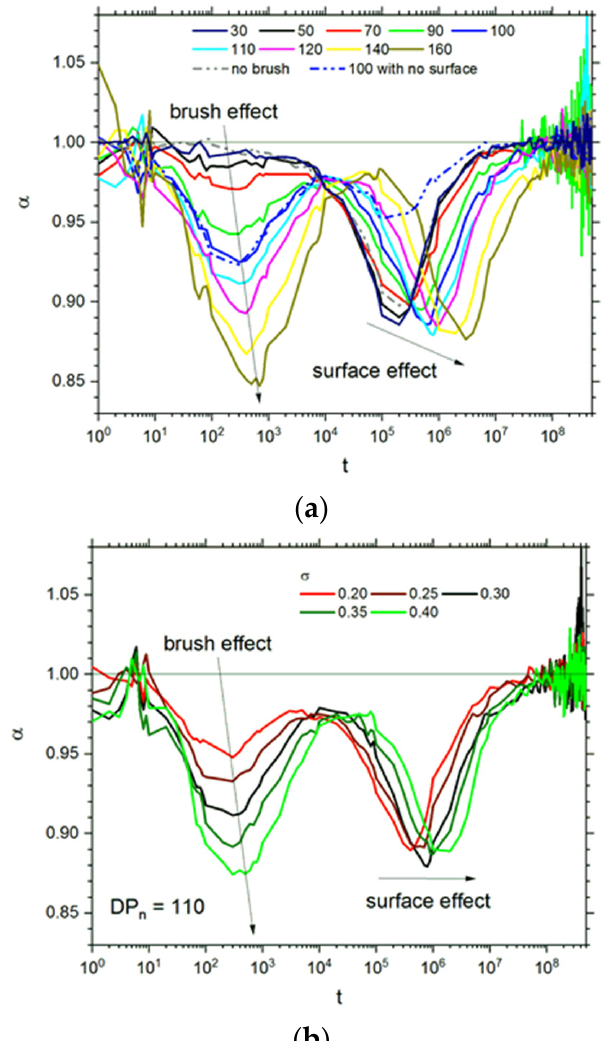
Figure 6. The exponent α (see text for details) as a function of time for various chain lengths at σ = 0.3 ( a ). Dashed lines represent the case of flat surfaces only (no chains) and surfaces without nongrafting surface sites (grafting chain ends were still immobile). The exponent α as a function of grafting density for DP n = 110 ( b ). The degrees of polymerization DP n and σ values are given in the insets. Long-timescale dynamics of the system is usually characterized by the self-diffusion coefficient D calculated from the mean squared displacement ∆ r 2 as D = ∆ r 2 /6 t . Values